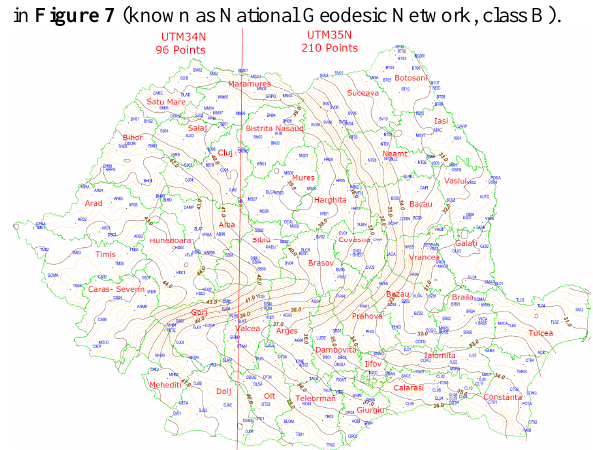
Figure 7 . Points distribution used to validate the final results and the Romanian quasigeoid undulation